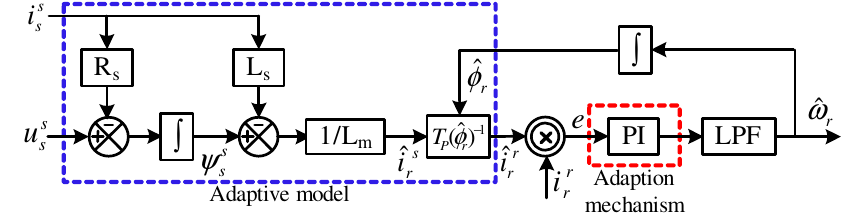
Figure 2. Block diagram of the traditional MRAO for control of DFIGs without incremental encoders.